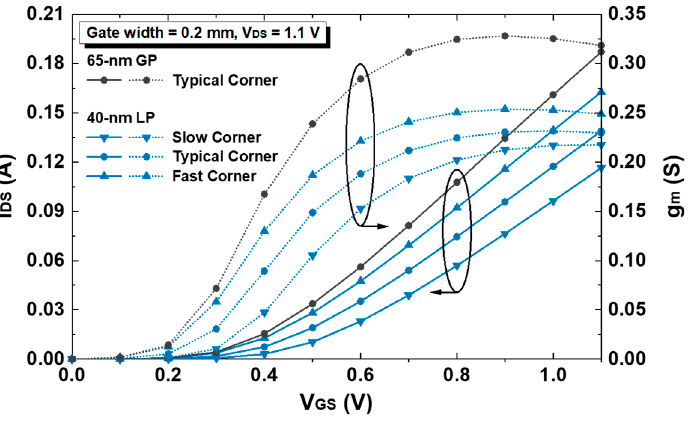
Figure 1. Comparison of current levels of NMOS of low- and general-power CMOS processes.